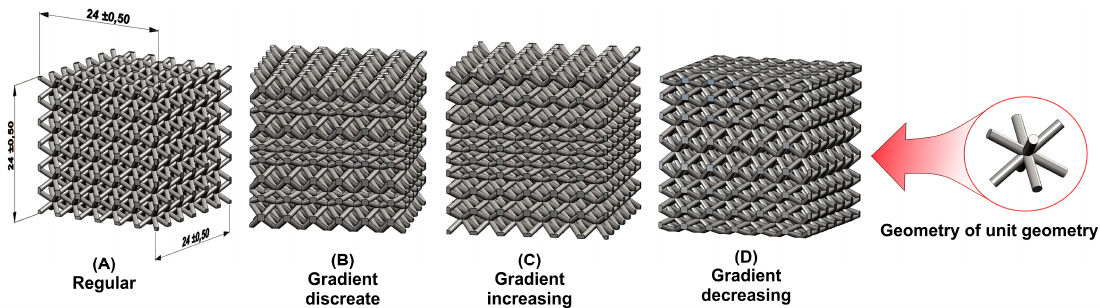
Figure 1. The general view of elaborated lattice structures.